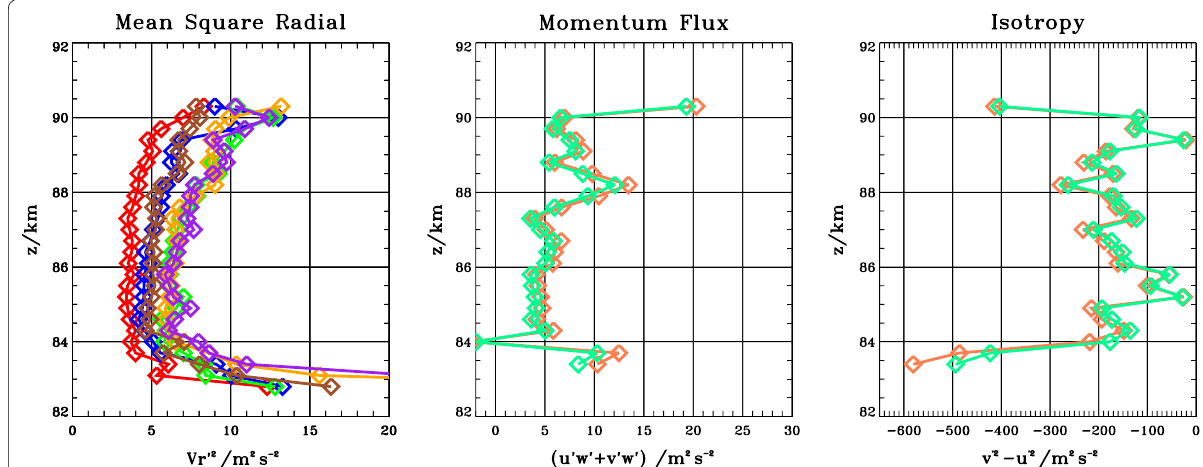
Fig. 9 Superscale mean square radial velocities (left), momentum fluxes (centre) and isotropies (right) for periods less than 12.8 h. Note that the isotropy scale is different from that in Fig. 8. The NE beam is somewhat noisy, and this contributes to the noise in the momentum flux. Note that the isotropy requires mean square radial velocities from four beams (NE, SW, N and W) to calculate, and it is particularly noisy. The colours for the momentum flux and isotropy indicate values uncorrected (green) and corrected (coral) for aspect